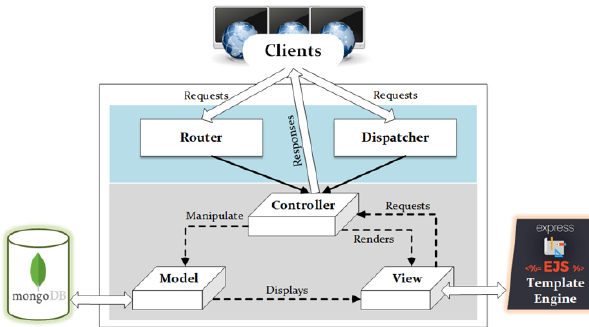
Figure 8. The architecture of database systems processing